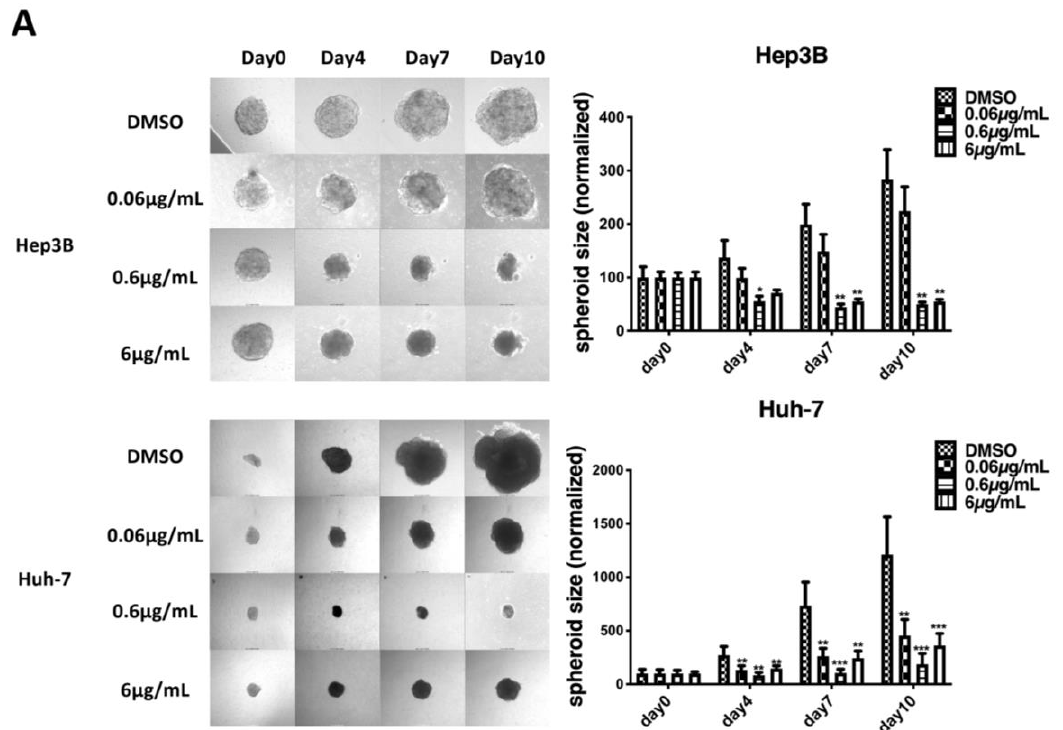
Figure 3. Cont . Figure 3.